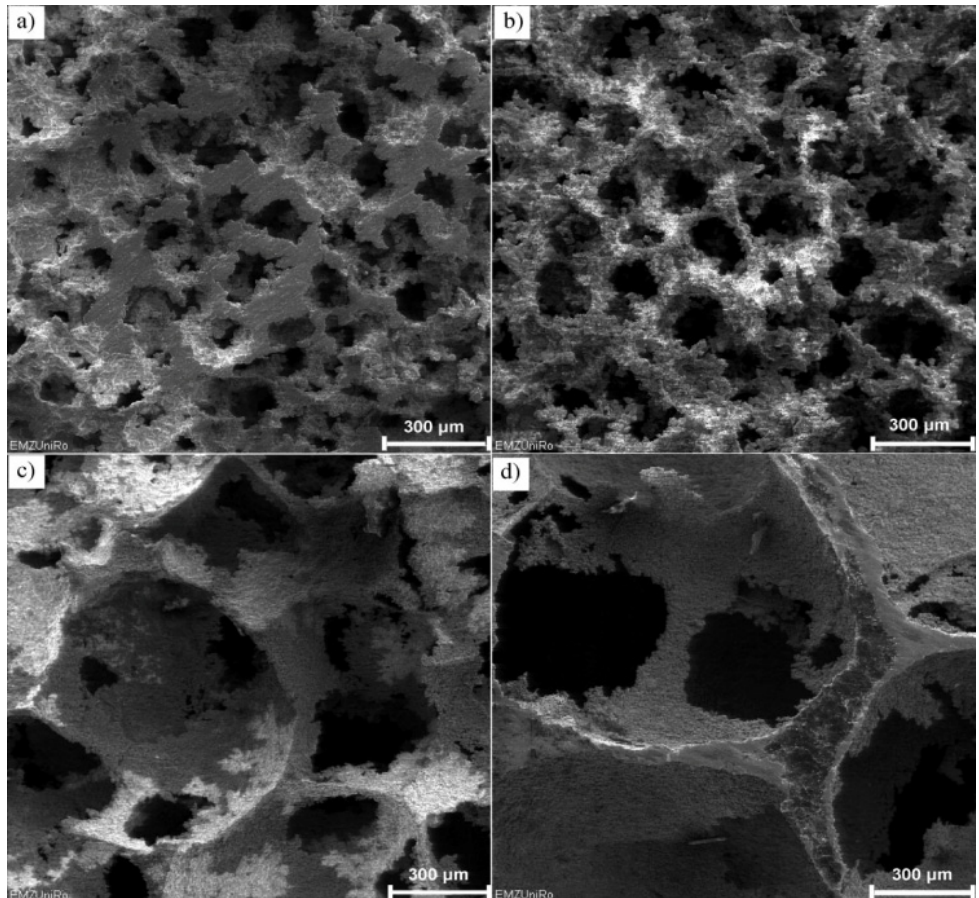
Figure 21. SEM micrographs of the porous titanium surfaces with the same porosity of 55% but different pore sizes of 125 ( a ); 250 ( b ); 400 ( c ); and 800 µm ( d ) [224]. Reprinted with permission from [224]. Copyright 2010 John Wiley and